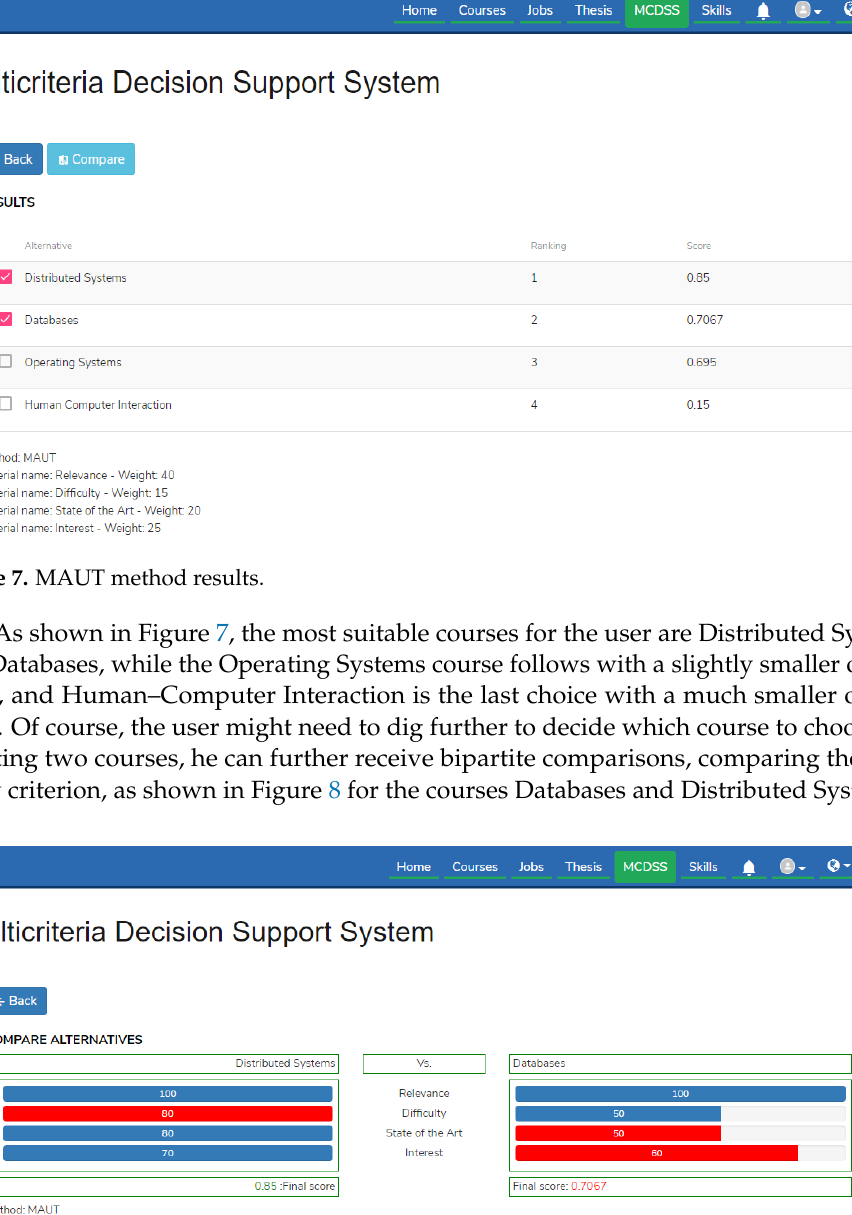
Figure 6. Multi-Criteria Decision Support service input.